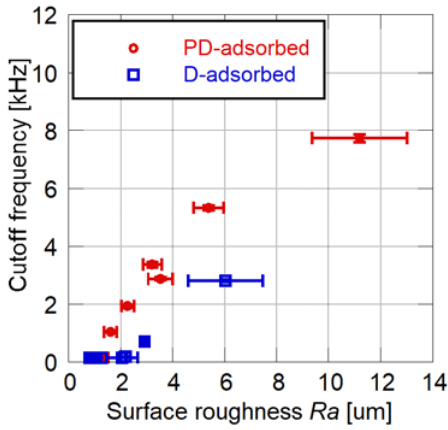
Figure 6. Relationship between cutoff frequency and surface roughness for the PD- and D-adsorbed PSPs.